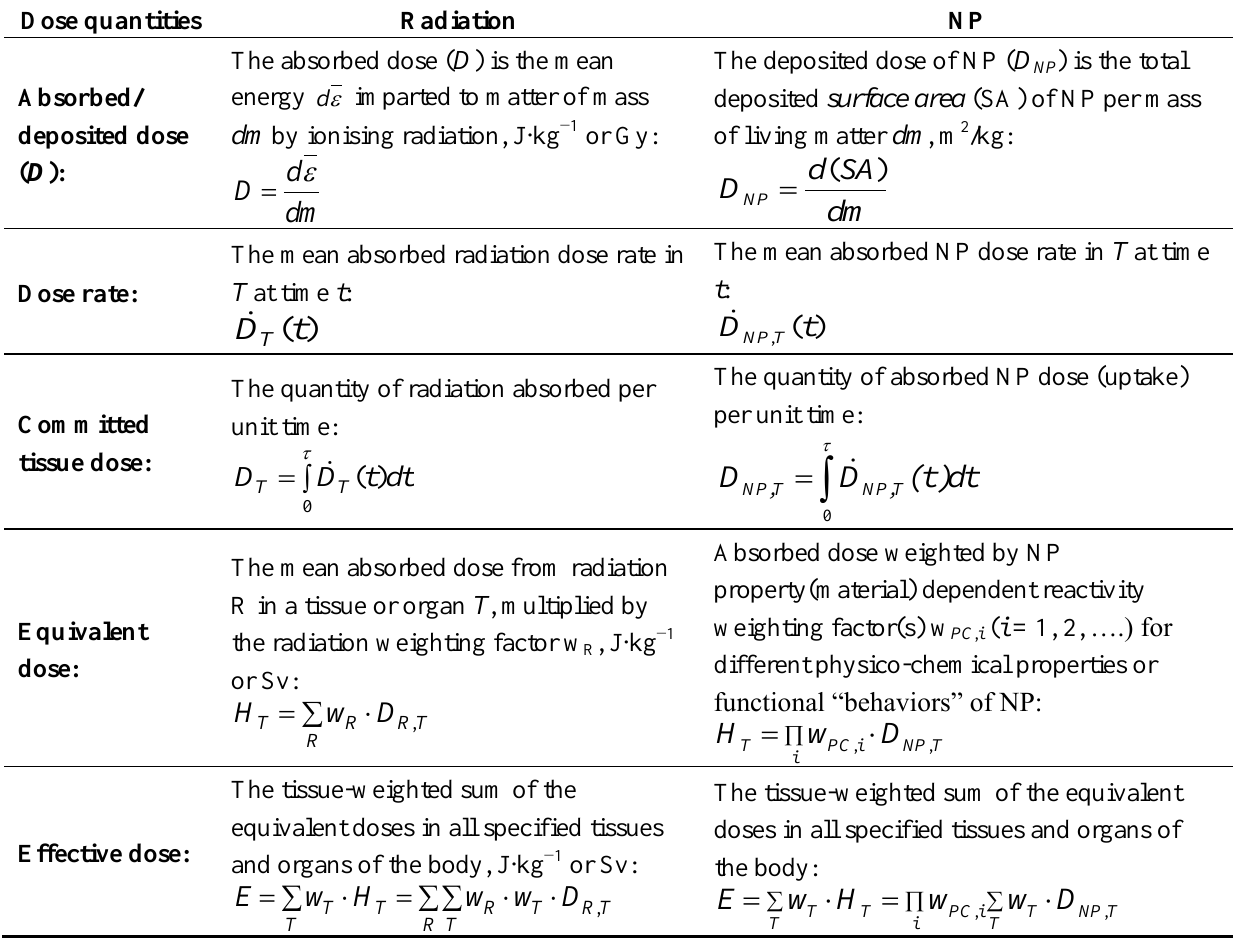
Table 1. Dose quantities for radiation and in analogy for nanotoxicology. Dose quantities Radiation